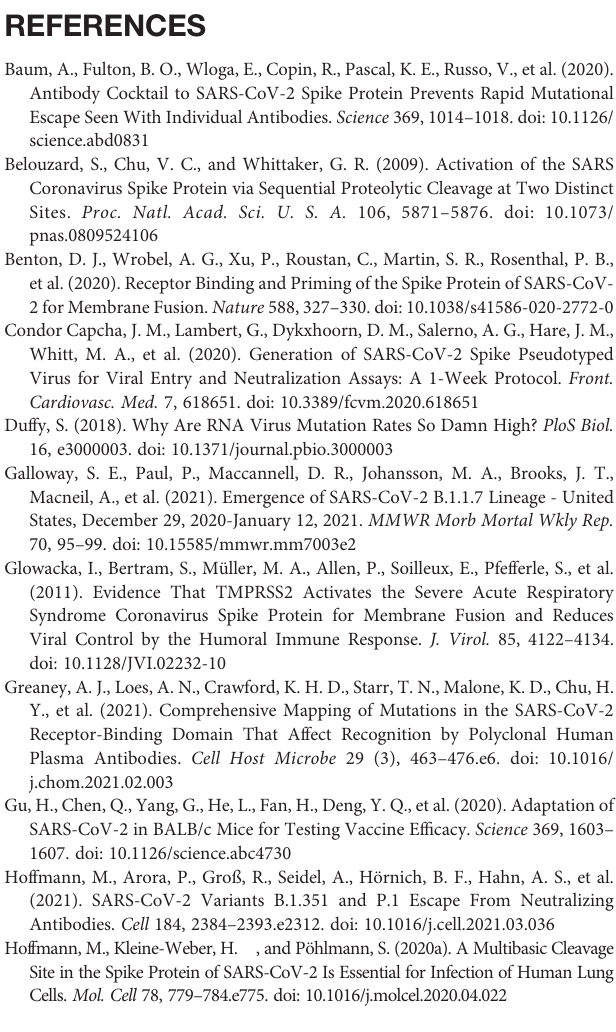
Supplementary Figure 1 | DNA sequencing results of S gene mutations of N501Y.V1, N501Y.V2-RBD and N501Y.V2. SARS-CoV-2 S genes were sequenced with Sanger ’ s DNA sequencing at GenewiZ Biotechnology Co., Ltd. The DNA sequences of SARS-CoV-2 S mutants were compared with SARS-CoV-2 WTSgenewithSnapGene software,and the relatednucleotide mutation siteswere marked in red boxes. Supplementary Figure 2 | Infection ef fi ciency of SARS-CoV-2 N501Y.V2 in mammalian cell lines. Infection ef fi ciency of SARS-CoV-2 WT, D614G, N501Y.V2 andN501Y.V2RBDvariantsin293T-hACE2 (A) ,Vero (B) ,293T-hACE2-TMPRSS2